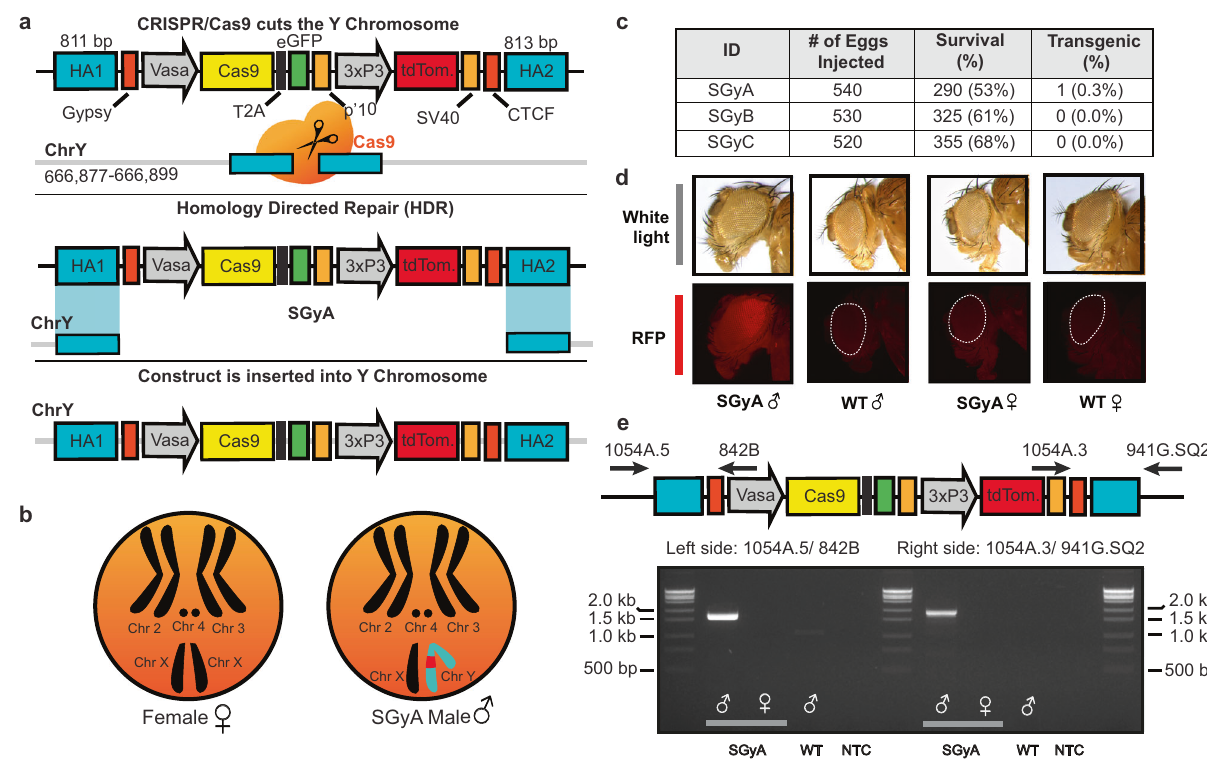
Fig. 1 Engineering a Y chromosome-linked Cas9 in D. melanogaster . a The Cas9 transgene design for Y chromosome insertion via CRISPR/ Cas9 − mediated cleavage and homology-directed repair (HDR). Homology arms (HA) fl ank two insulator sequences, GypSy and CTCF, and a vasa- controlled Cas9 − T2A-eGFP. An eye-speci fi c marker (Tdtomato) allows for the identi fi cation of transgenic fl ies carrying the transgene. For microinjection, a source of Cas9 and gRNA were provided to cleave the Y chromosome. The SGyA template was provided and inserted into the Y chromosome through HDR. b Karyotype of transgenic SGyA males and non-transgenic females. c The number of embryos injected for the SGyA, SGyB, and SGyC transgenes, survival to the larval stage of injected embryos, and rate (no. of independent transgenic individuals found/no. of embryos injected) is shown. No transformants were obtained for SGyB and SGyC. d White light and fl uorescent images of the SGyA line compared to WT. There is an overall faint yet distinguishable expression of the fl uorescent marker in SGyA individuals. Please refer to Fig. S1 to see the range of fl uorescence in the SGyA eye marker. e PCR con fi rmation of transgenic male fl ies harboring the SGyA transgene. Primers corresponding to the left and right genomic insertion regions were used to amplify both sides to ensure the transgene was present. Ampli fi cation was performed at least twice by two independent scientists. The expected band size for the left side primer pair is 1.690 kb. The expected band size for the right side primer pair is 1.893